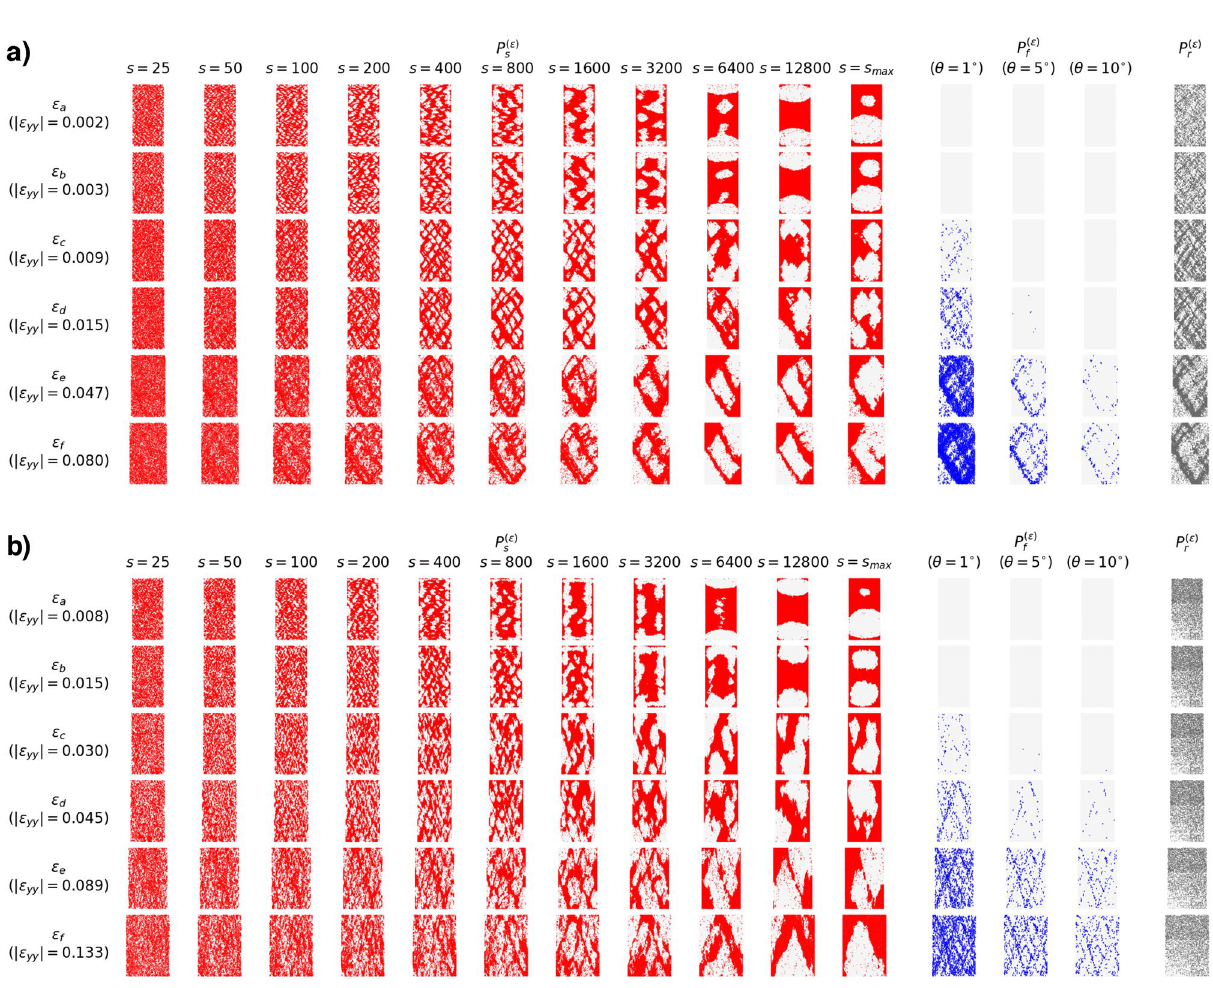
Figure 3. Visualization of patterns characterized by the proposed s -LID ( P (ε) P (ε) r ) at different stages of the loading history in PSS for systems ( a ) 20K, techniques: BFC ( P f ), and rotation ( and ( b ) 20K-NR. Note no clear rotation pattern can be seen in sample 20K-NR since rotation is completely